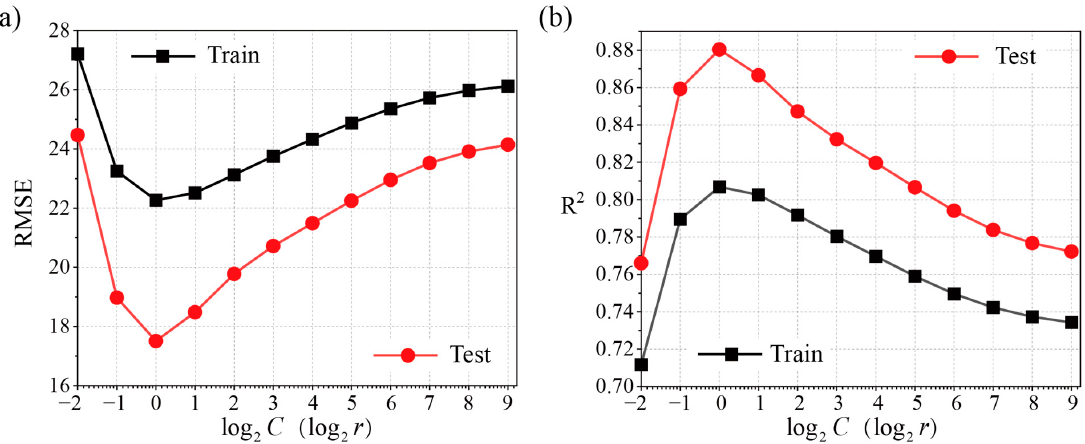
Figure 5. Comparison of the KELM models using various performance indicators in the training and testing phase: ( a ) RMSE; ( b ) R 2 .